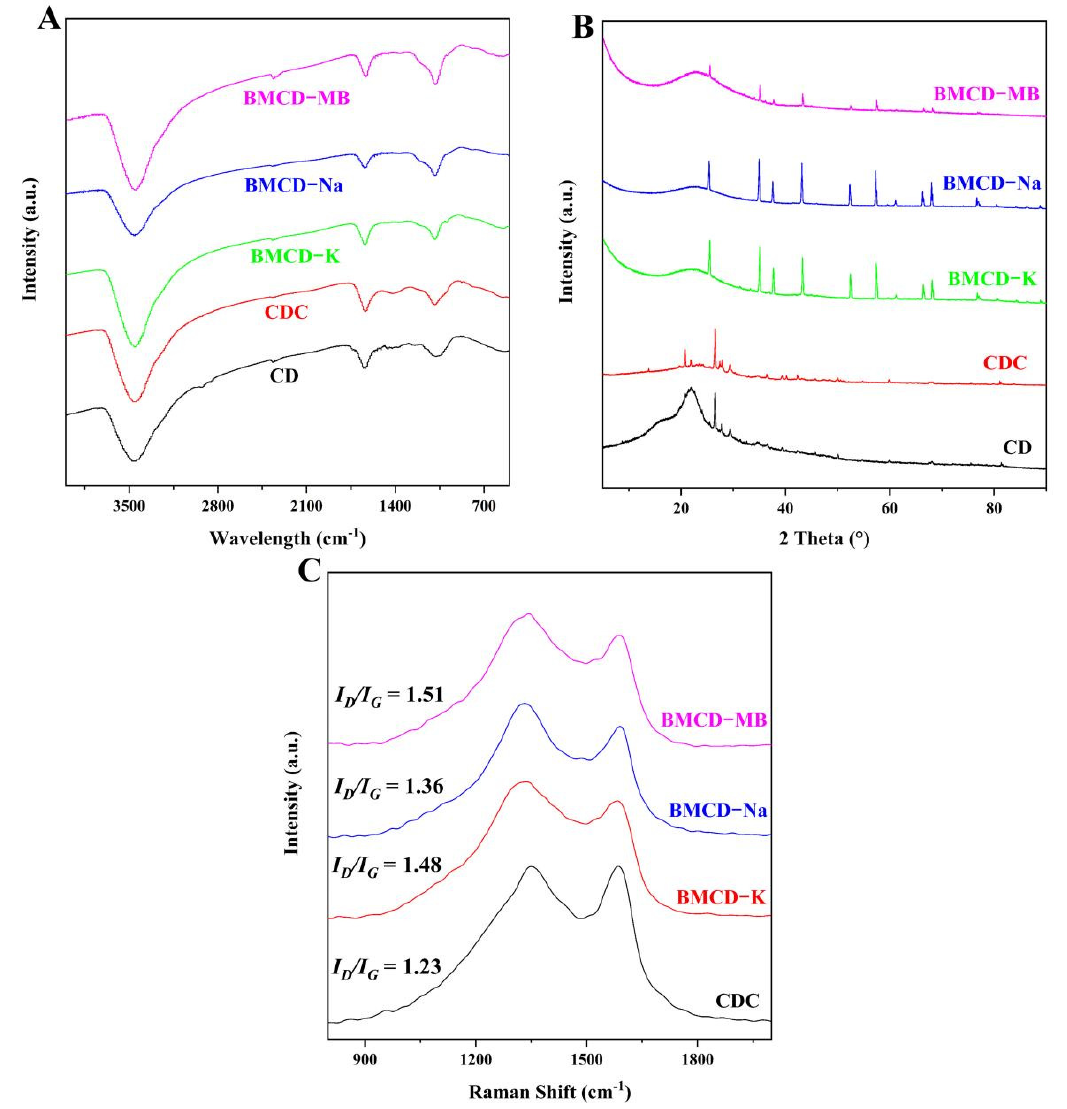
Figure 2. ( A ) FT-IR spectra, ( B ) XRD pattern, and ( C ) Raman spectra of biochar materials.